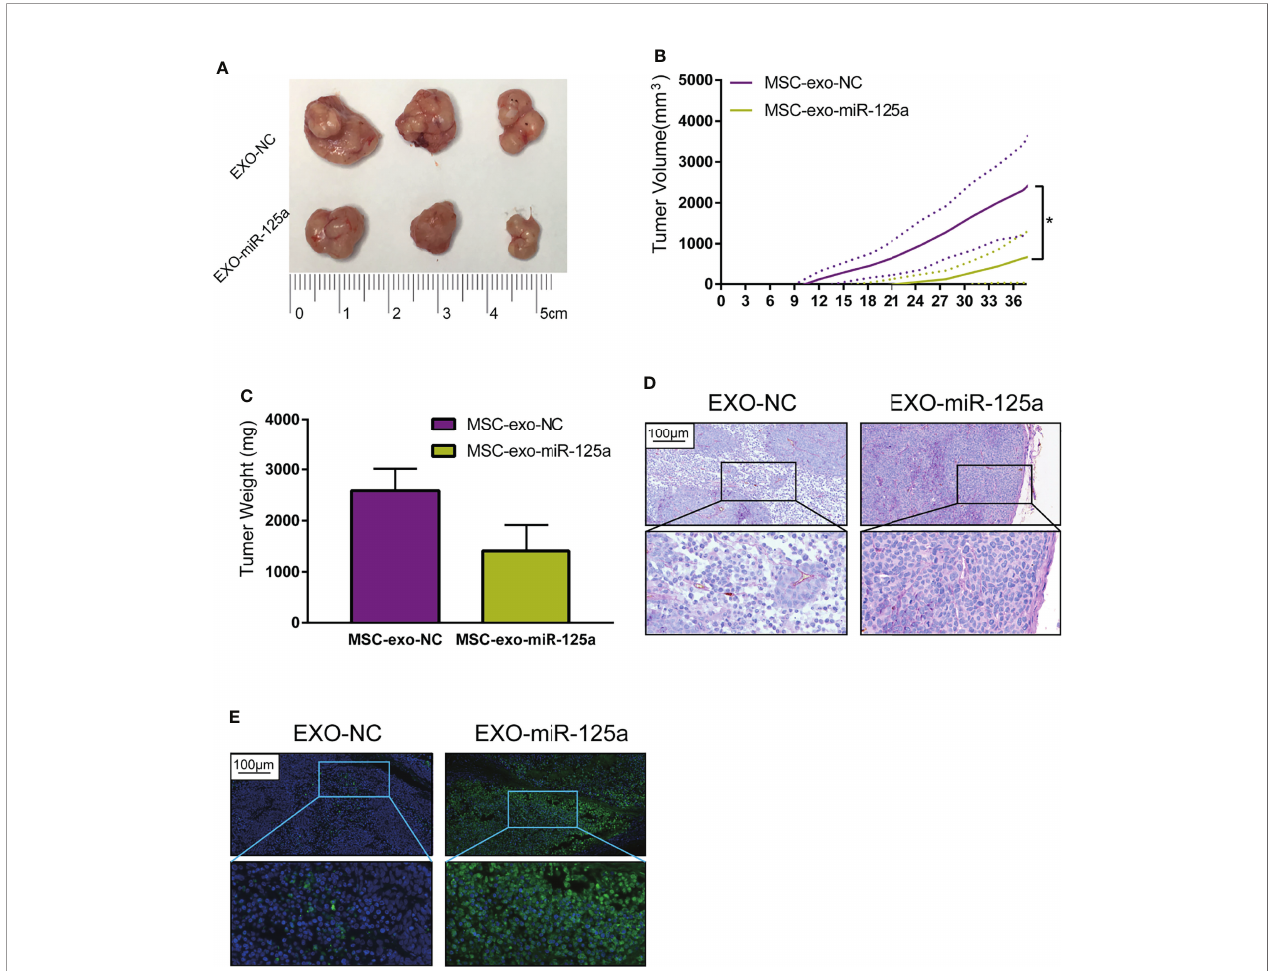
FIGURE 6 | EXO-miR-125a suppressed tumor growth and VM formation in vivo . Mice were subcutaneously injected with 6 – 10B cells, and treated by exosomes. (B) Tumor volumes were monitored every 3 days. (C) After sacri fi ce, tumor weights were measured. (D) Representative images of the tumor HE staining and CD34- PAS staining of VM structures. (E) Representative images of tumor sections processed in the TUNEL assay (*P <